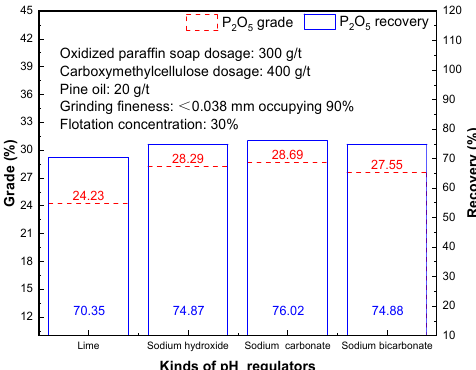
Figure 9. E ff ect of di ff erent pH regulators on extracting Figure 9. Effect of different pH regulators on extracting phosphorous. Figure 9. Effect of different pH regulators on extracting phosphorous.